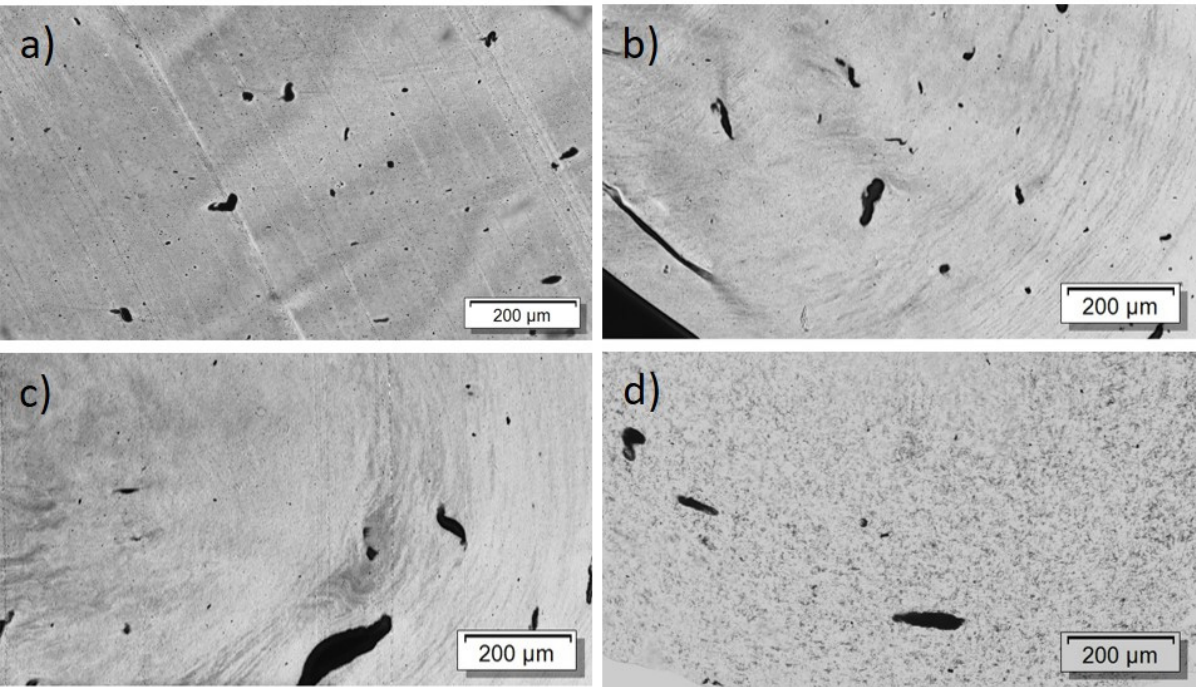
Figure 5. Transmission light microscopy images of PC/2 wt% Tuball TM with different amounts of PEG: ( a ) without PEG, 2 wt% PEG ( b ), 3 wt% PEG ( c ), 8 wt% PEG ( d ).